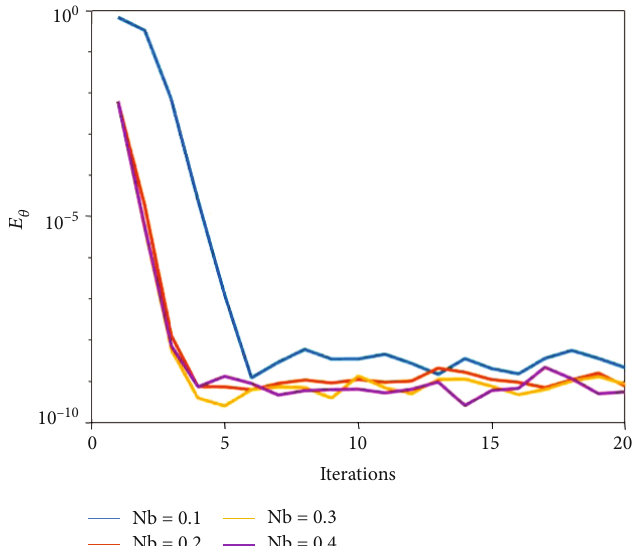
: 8, ξ = 1, N N Df = Bi = Sr = 0 : 5, He b = t = w = 0